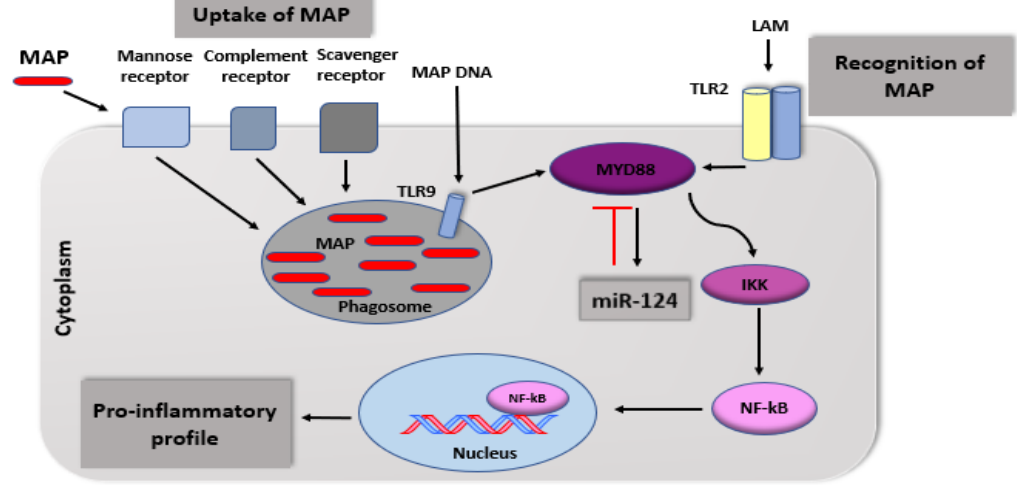
Figure 2. Immune recognition and phagocytosis of MAP in CD macrophages.